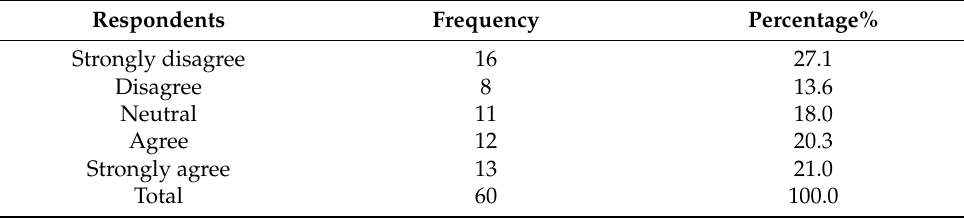
Table 15. We have a competitive advantage over our competitors.